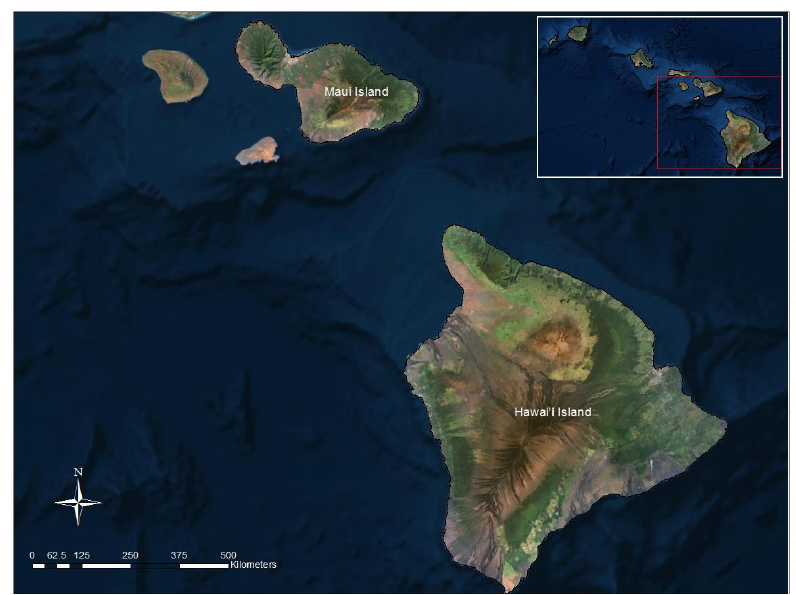
Figure 1. Administrative boundary of Hawaii and Maui Islands.